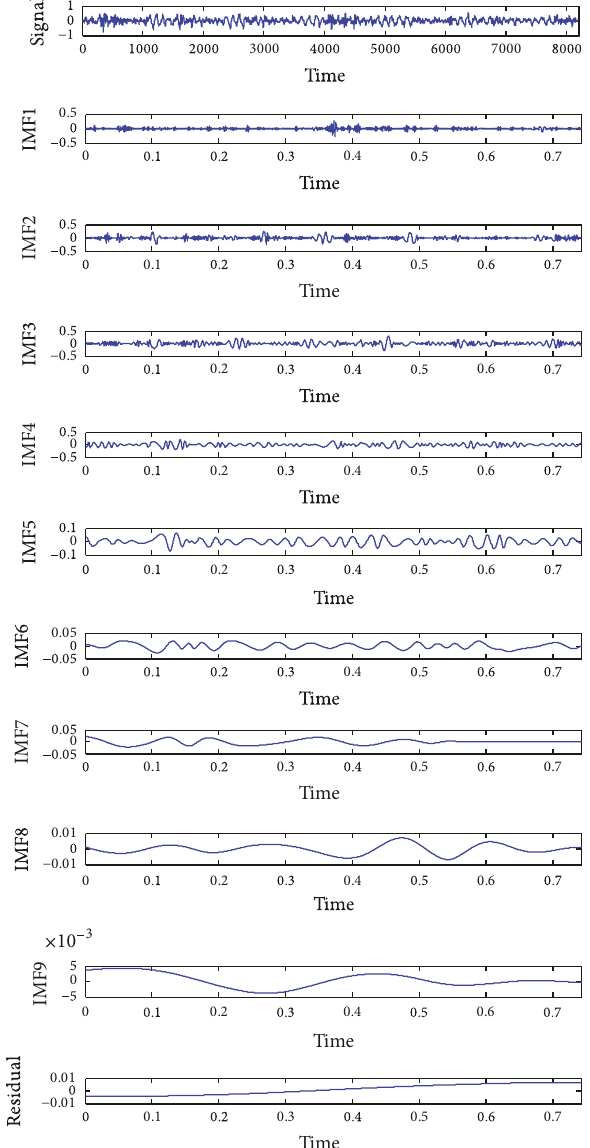
Figure 7: The IMFs of ship radiated noise A decomposed by